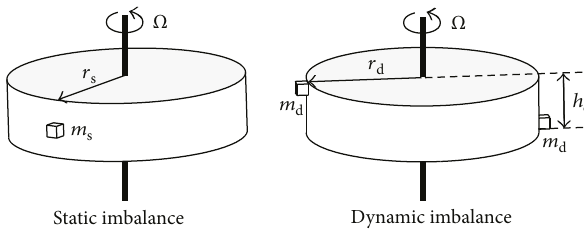
Figure 11: The static and dynamic imbalances of the fl